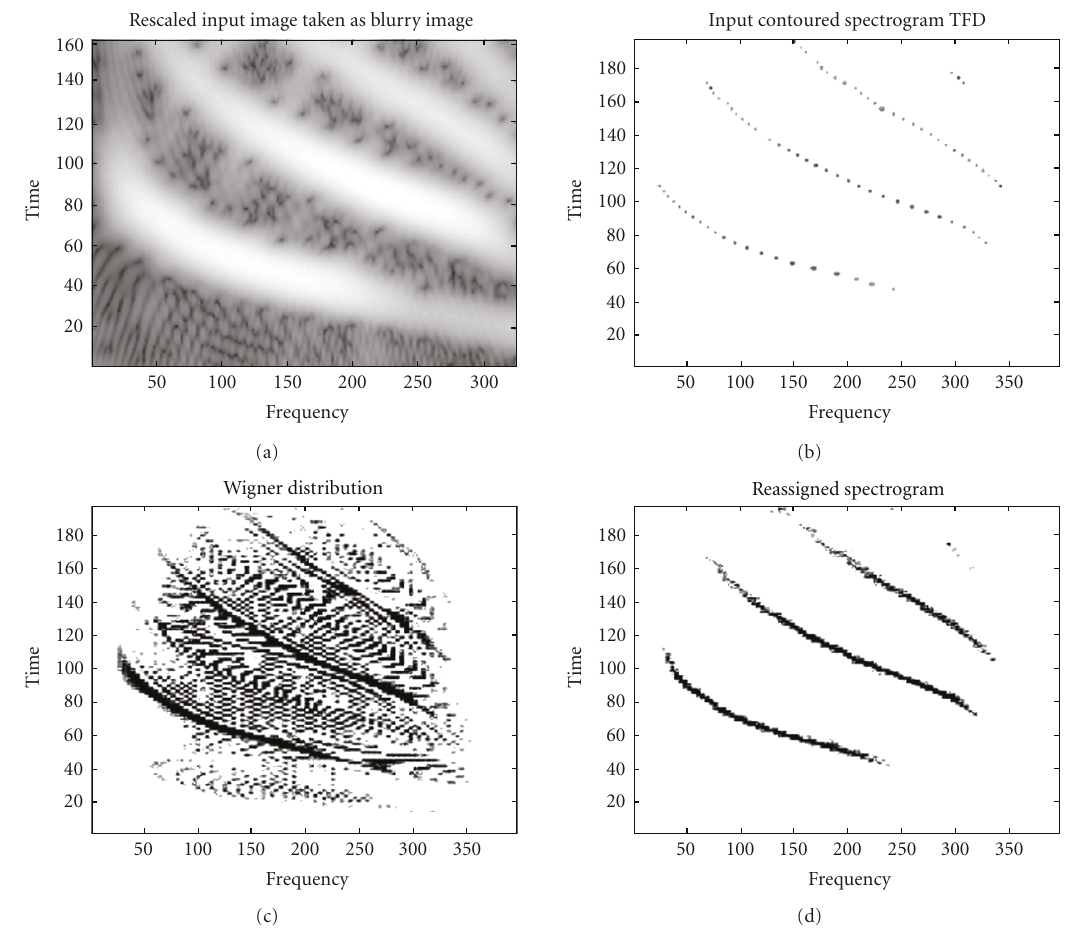
Figure 23: Various TFDs for bat chirps signal, (a) the spectrogram (test TFD), (b) NTFD [178], (c) WD, and (d) reassigned TFD